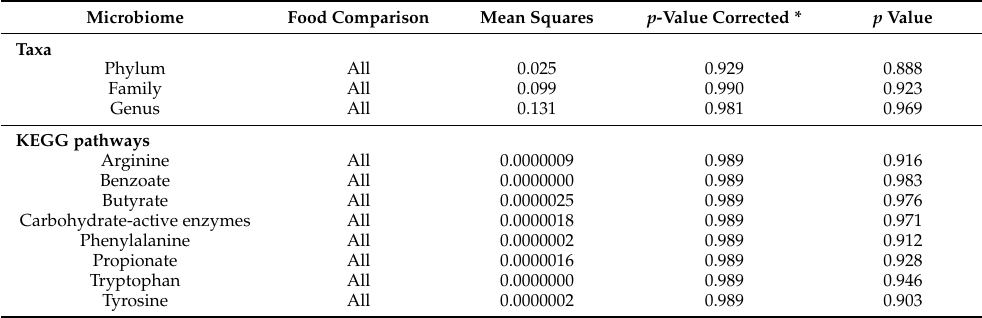
Table 6. PERMANOVA analysis of bacterial taxa and KEGG pathways in feces from dogs that consumed the study foods. Microbiome Food Comparison Mean Squares p -Value Corrected * p